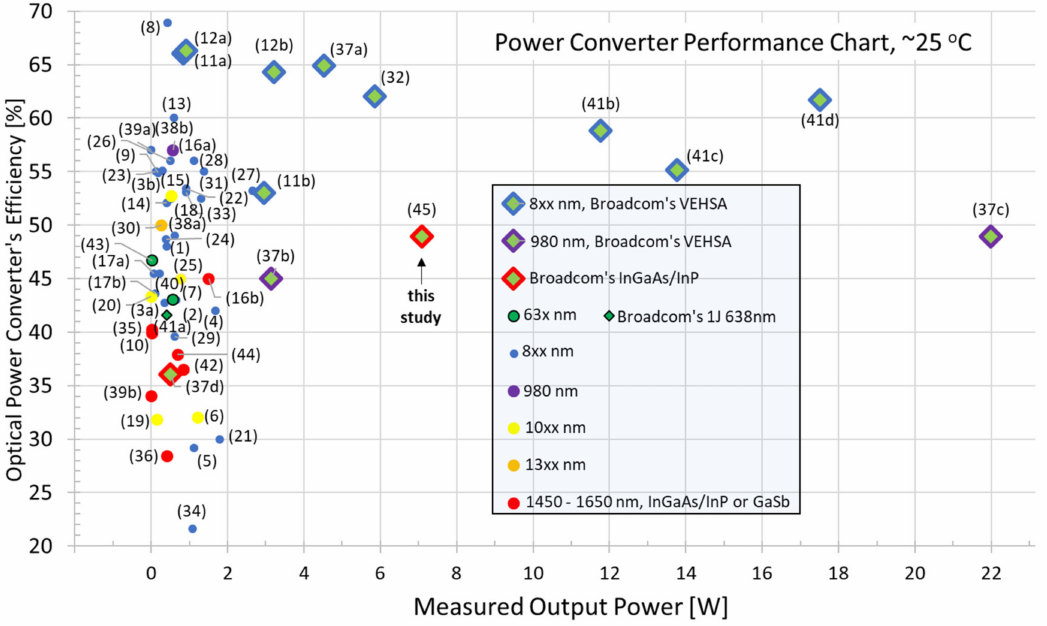
Figure 2. Survey of the measured performance for monolithic power converter devices at the indicated laser wavelengths. Single junction, vertical multijunction, and planar segmented (“pizza” configuration) device reports are included (module results are not included here). Updated